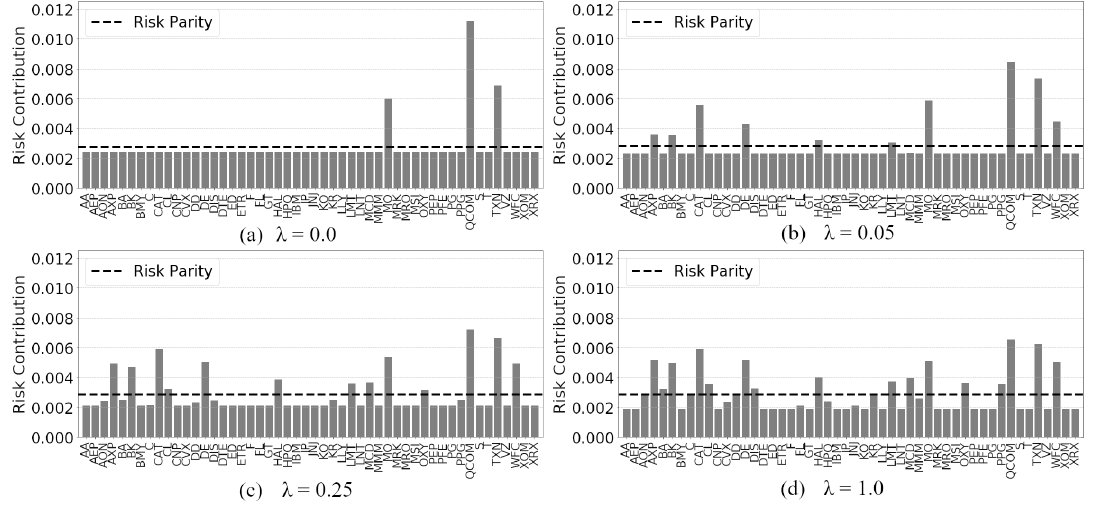
Figure 5. Risk allocations change with penalty λ -Model (B)—1.2x Target